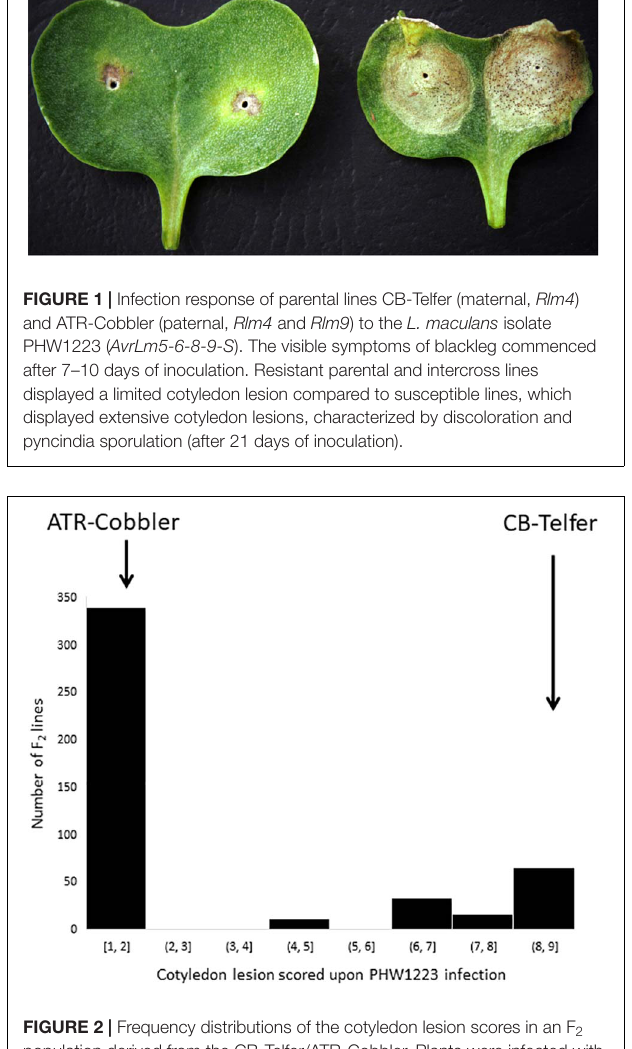
FIGURE 2 | Frequency distributions of the cotyledon lesion scores in an F 2 population derived from the CB-Telfer/ATR-Cobbler. Plants were infected with a single-spore isolate, PHW1223, at the cotyledon stage. Parental means are shown with arrows.